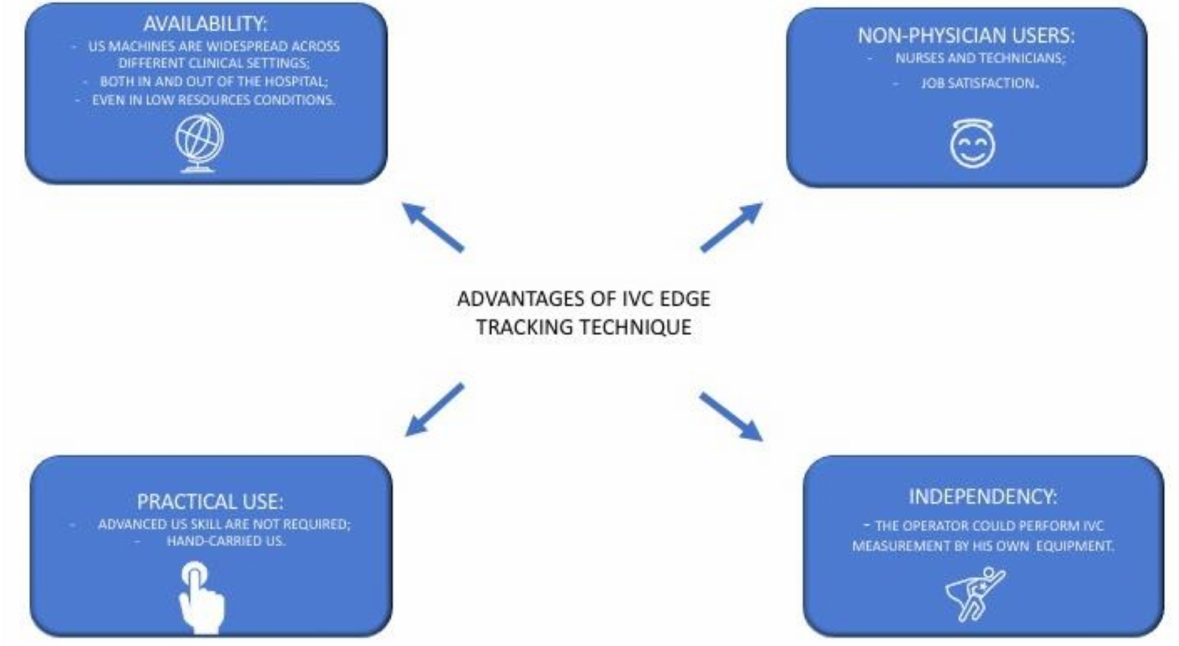
Figure 5. Main advantages that could be provided by an extensive use of US IVC edge tracking echocardiography ( see text for further explanations